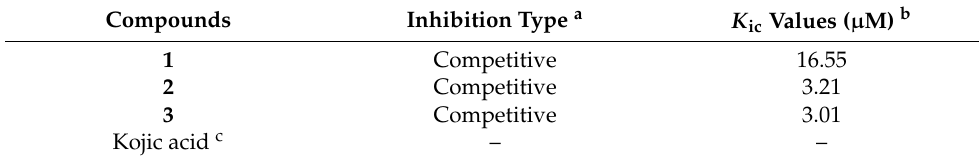
Table 3. Kinetic studies of compounds 1 – 3 against mushroom tyrosinase.